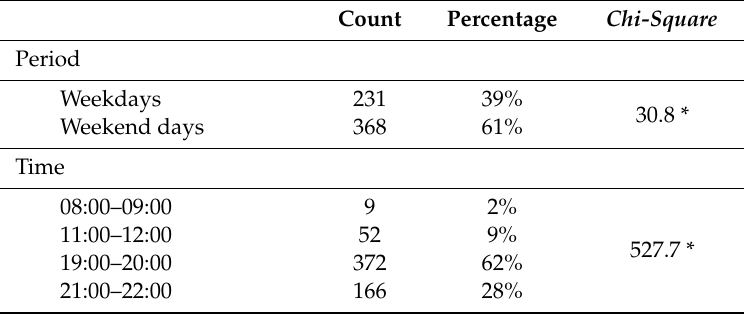
Table 1. Results from the systematic observation and video